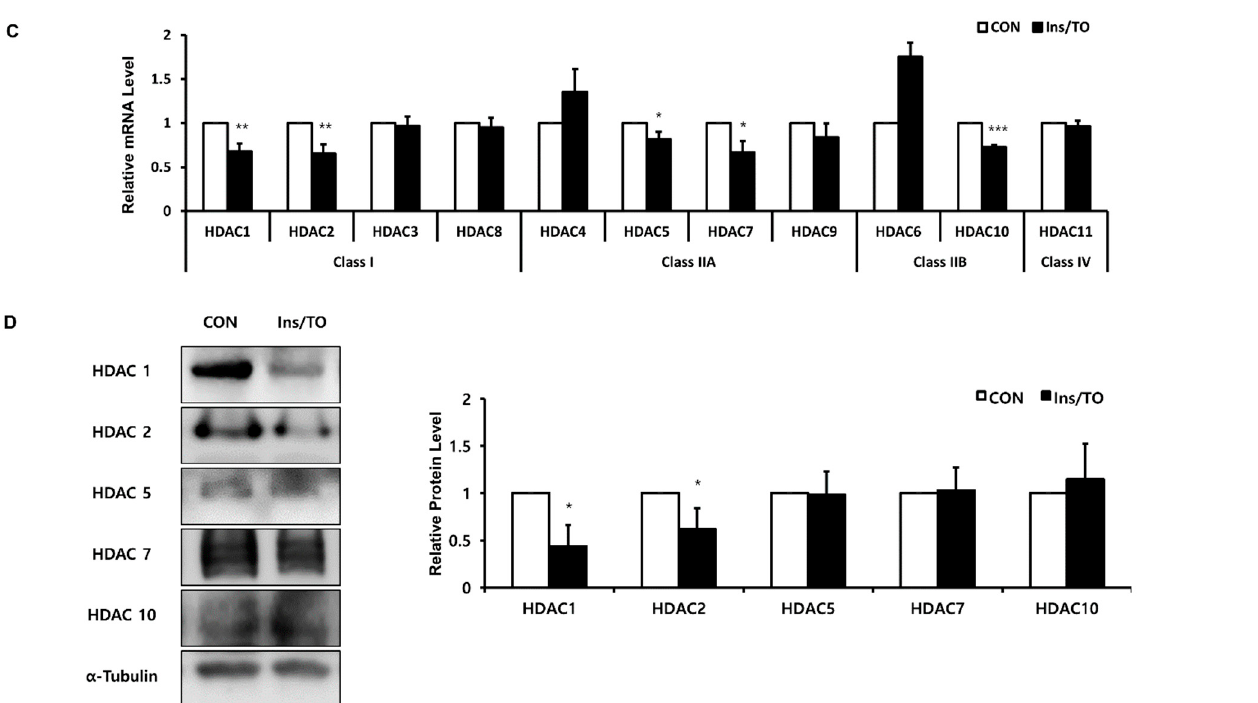
Figure 3. Decreased histone deacetylase (HDAC) activity and HDAC1 and HDAC2 expression levels during lipogenesis in SZ95 cells. ( A ) Total HDAC activity of SZ95 cells analyzed using an HDAC assay kit 48 h after insulin and liver X receptor (LXR) agonist (Ins/TO) treatment. ( B ) Relative HDAC mRNA expression in SZ95 cells analyzed using quantitative real-time PCR and normalized to that of HDAC1. ( C ) HDAC mRNA expression analyzed using quantitative real-time PCR and normalized to that of 36B4. ( D ) HDAC protein expression measured using Western blotting 48 h after Ins/TO treatment. Bar graphs show densitometric quantitation of HDACs as ratios to α -Tubulin, which was used as the loading control. Data represent the mean ± SD from three independent experiments ( n = 3). * p < 0.05, ** p < 0.01, *** p < 0.001 vs. control.